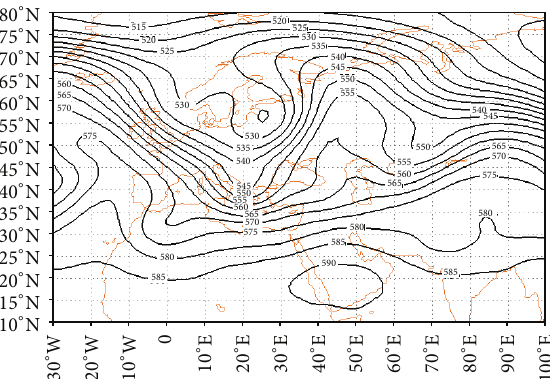
Figure 12: 500 HPa geopotential height level map.